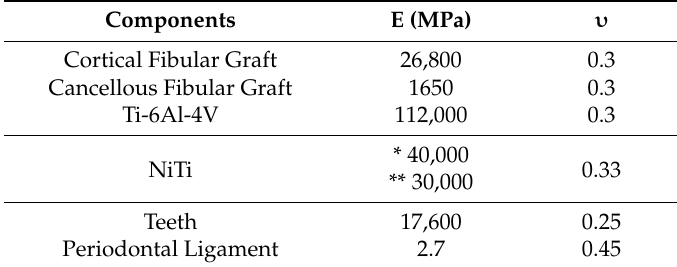
Table 2. Material properties of the Finite Element Model components. (Unit: megapascal or